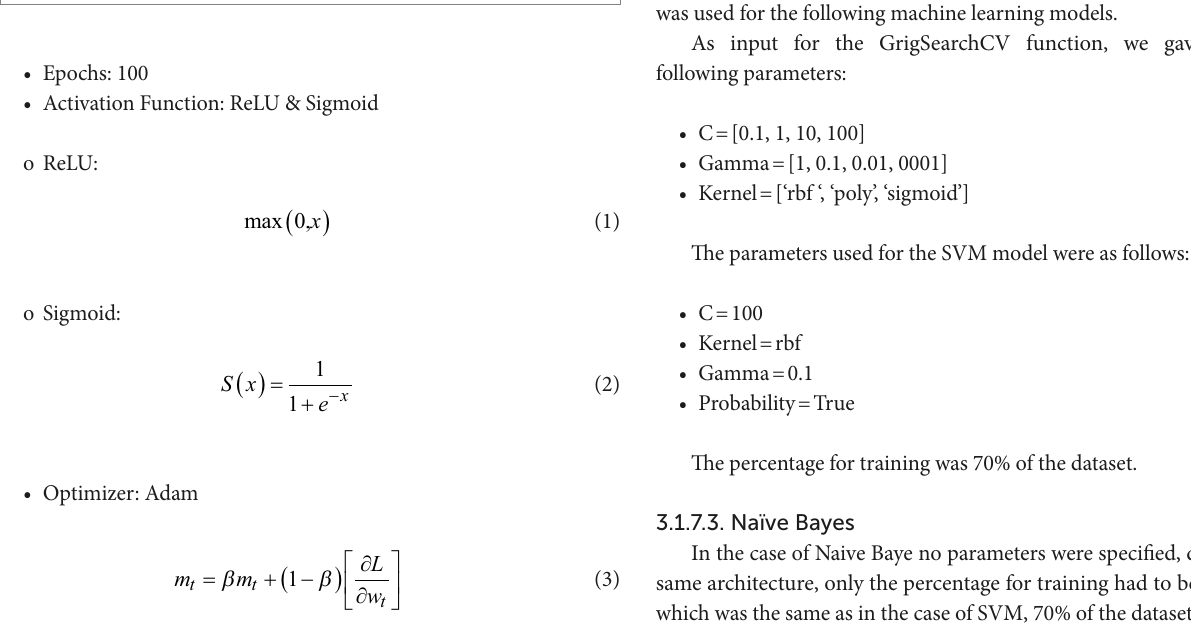
FIGURE 4 Pearson’s correlation